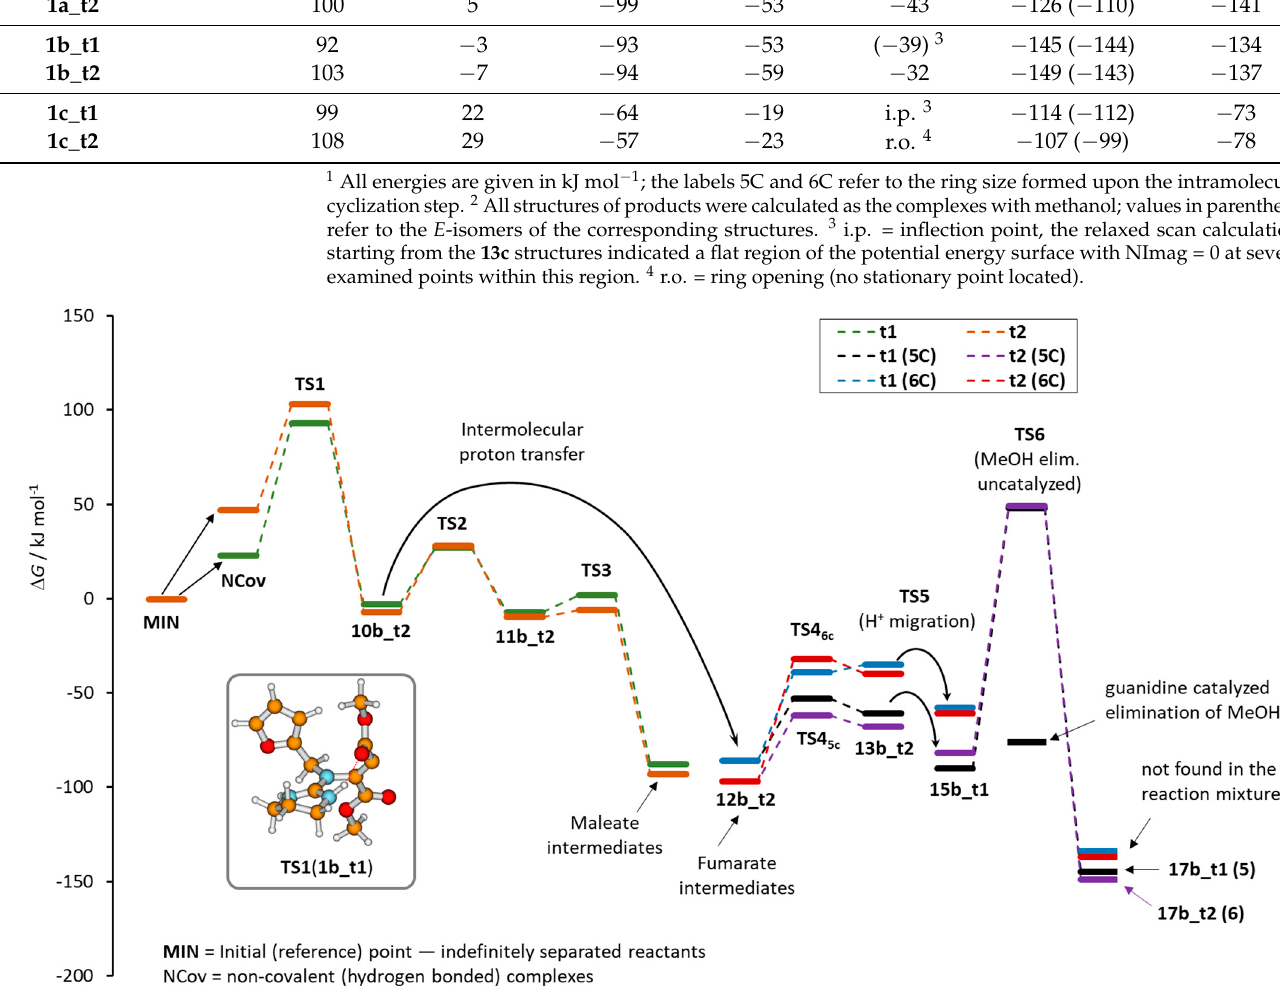
Figure 3. Energy profile for the reaction of the tautomers 1b_t1 and 1b_t2 with DMAD . The labels 5C and 6C relate to the ring size formed upon the intramolecular cyclization step. Only the lowest energy structures are labeled. Table 1. The relative Gibbs energies calculated for the selected structures along the reaction paths 1 .